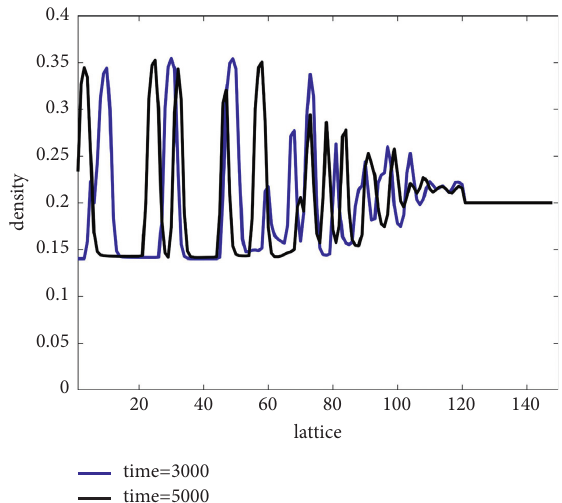
Figure 4: Density profile of all lattices.